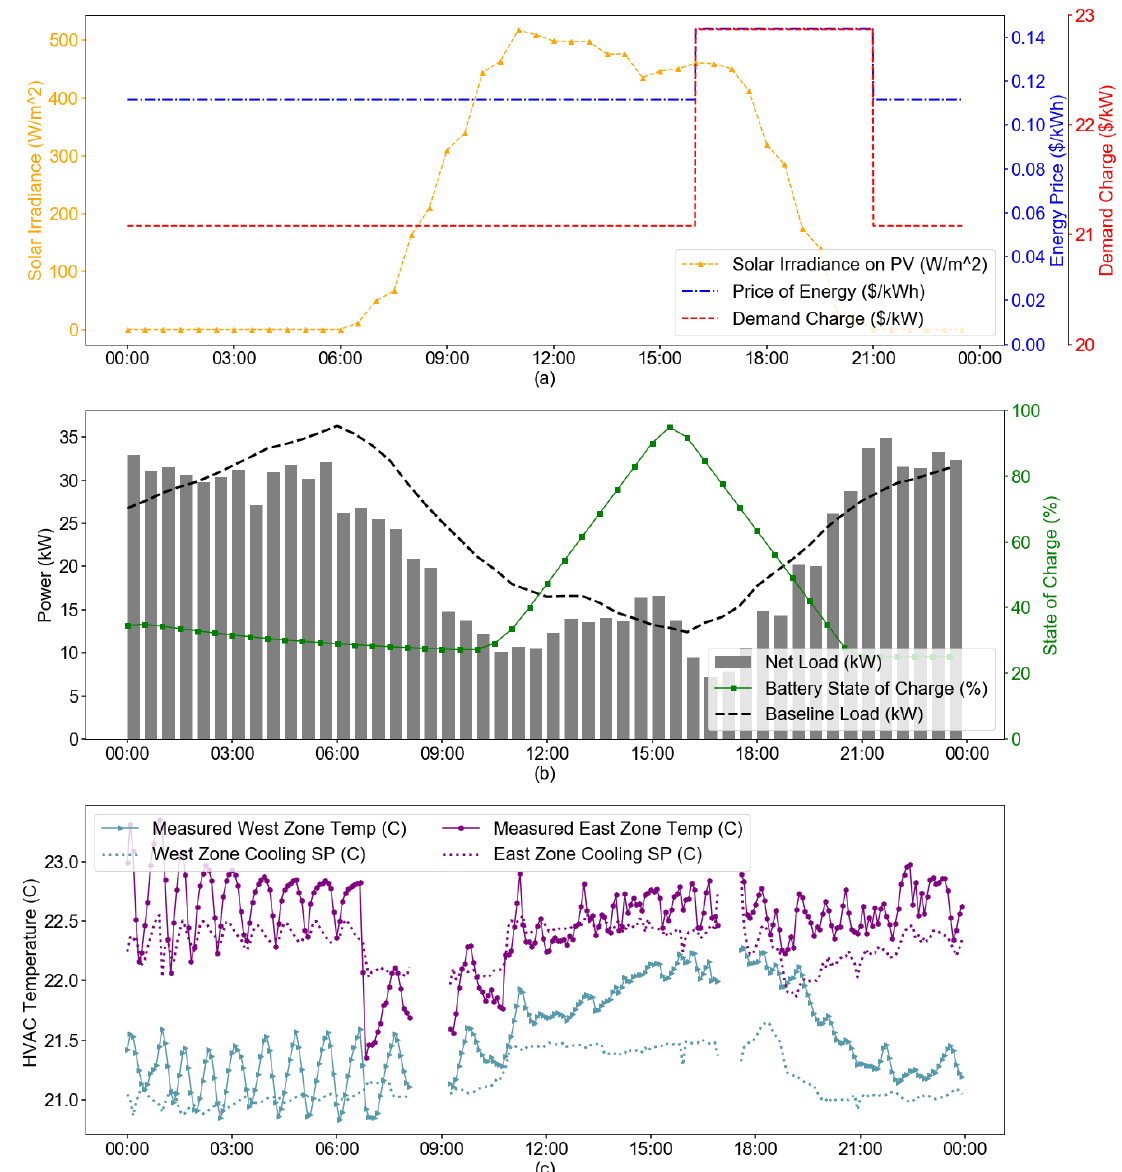
Figure 9. ( a ) SPO’s response to a TOU tariff with both demand charges and energy costs and varying solar irradiance. ( b ) The battery is used effectively for reducing net load during peak price hours. ( c ) SPO changes the thermostat setpoints to vary the zone temperature. Preferred temperatures: 20.56 ◦ C (69 ◦ F) for the West Zone and 21.67 ◦ C (71 ◦ F) for the East